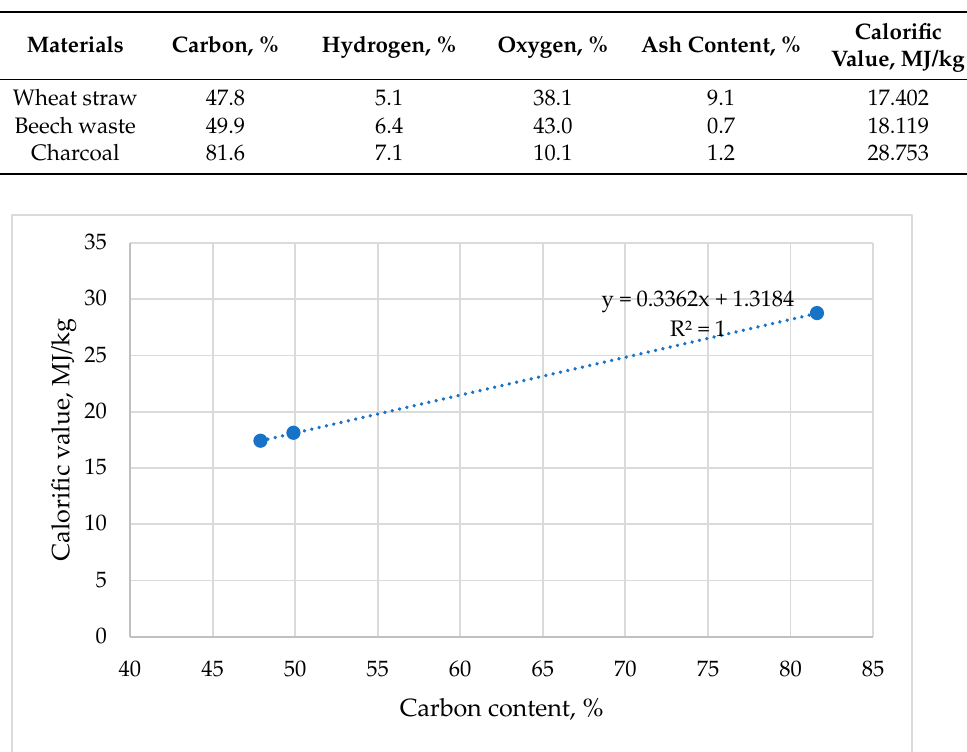
Table 2. Modelling of the calorific value of wheat straw according to chemical elements.